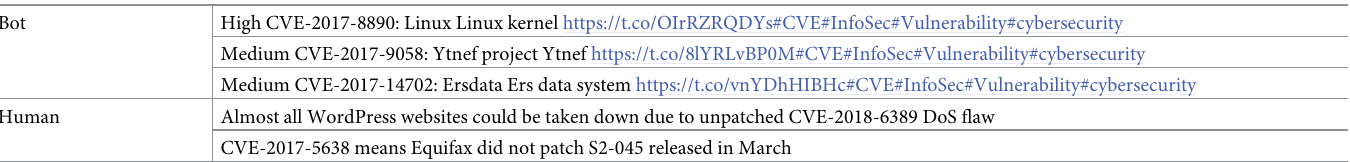
Table 4. Examples of tweets with vulnerabilities spread by users predicted to be bots versus humans.